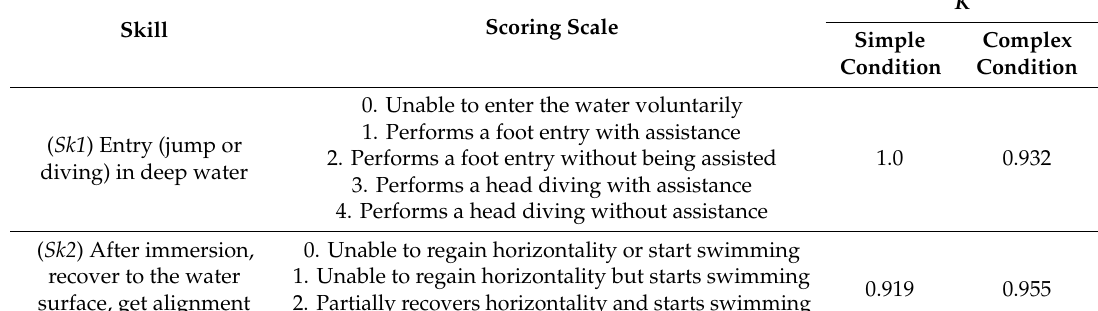
K Simple Complex Condition